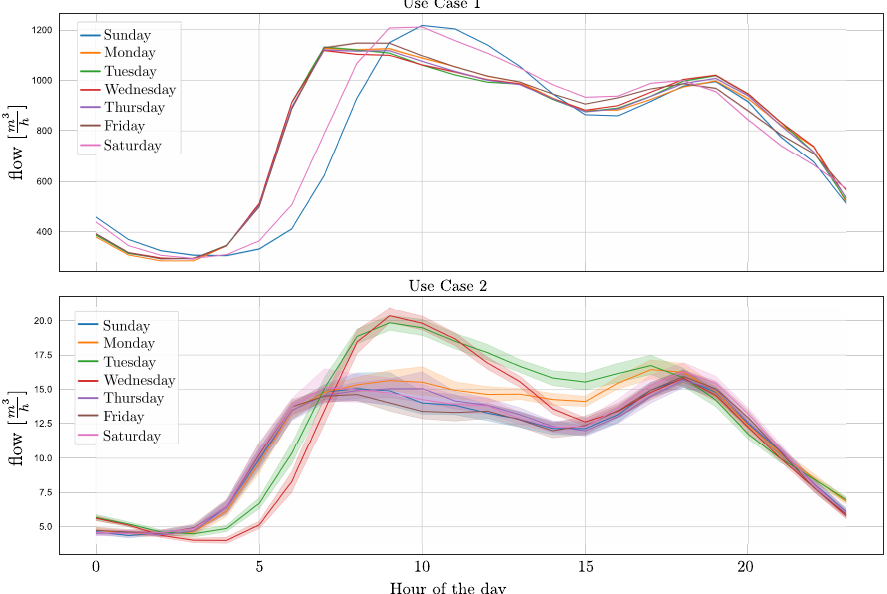
Figure 4. Mean daily consumption profiles with standard deviation from the use cases for the seven days of the week